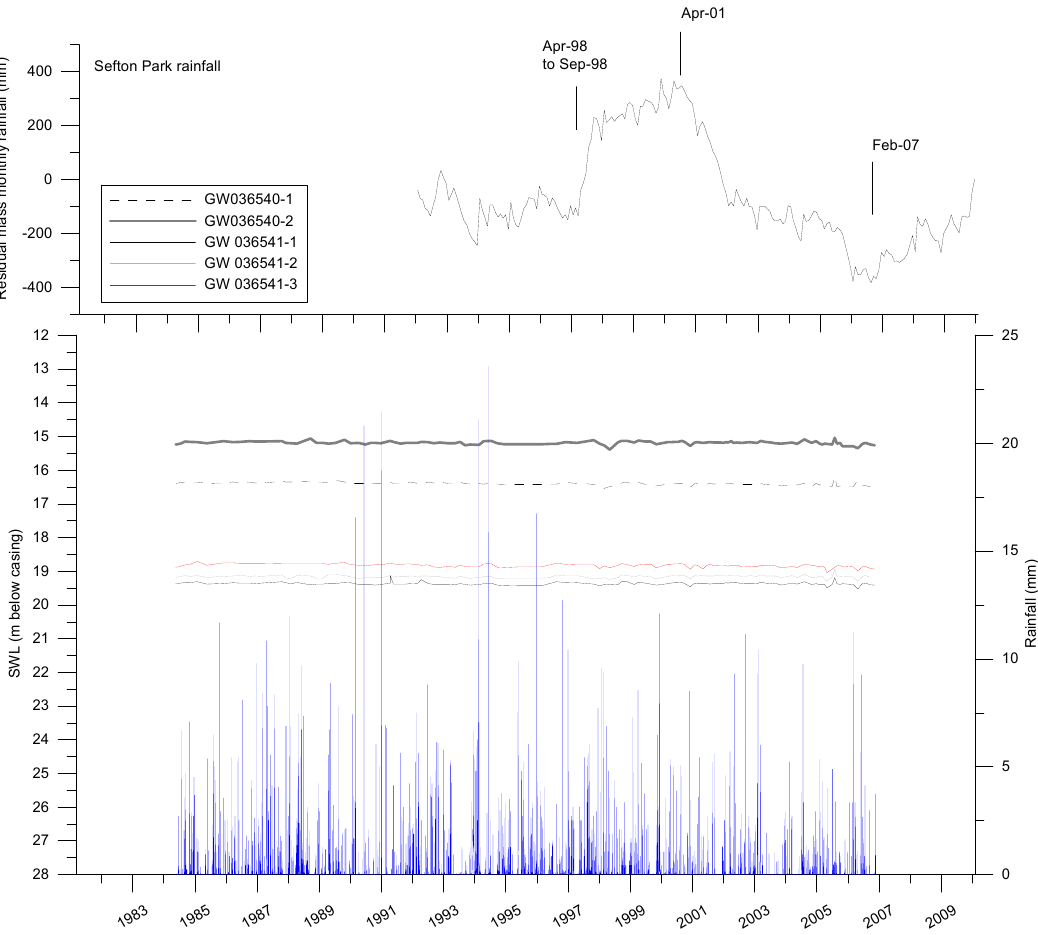
Fig. 8. (a) The residual mass curve for monthly rainfall at the Sefton Park and (b) groundwater levels (1985 to 2009) compared with daily rainfall.